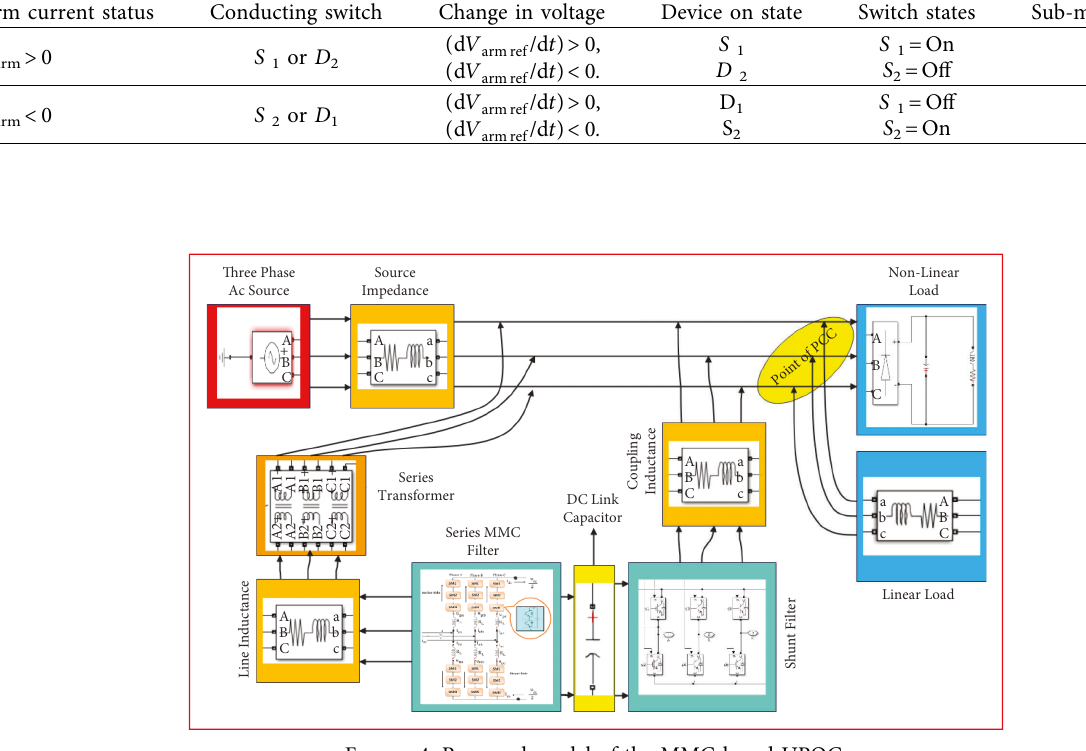
Figure 4: Proposed model of the MMC-based